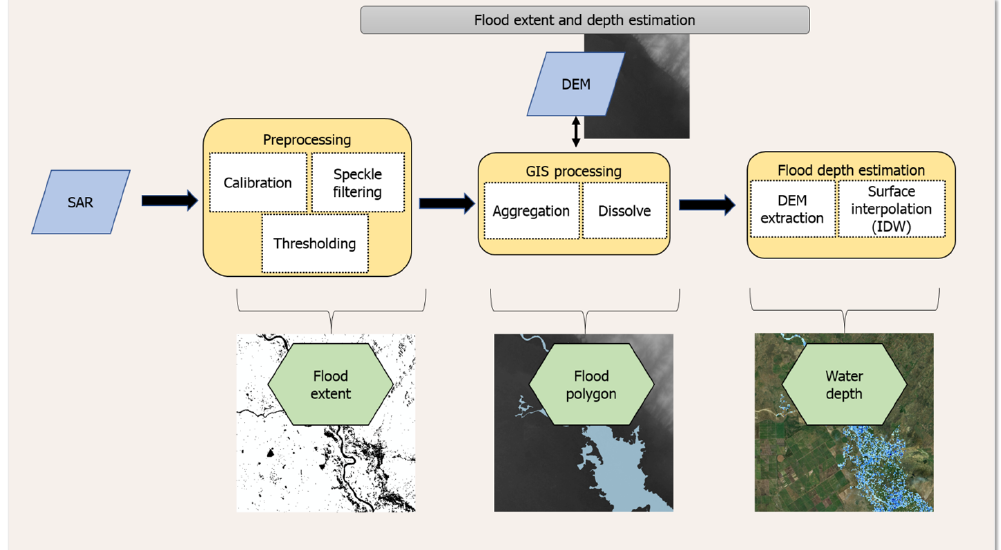
Figure 4. The workflow representing the extraction of SAR satellite imagery and deriving its corresponding water depth. The flood polygon is shown on a SRTM DEM image, and the water depth map is shown on a © Google Satellite